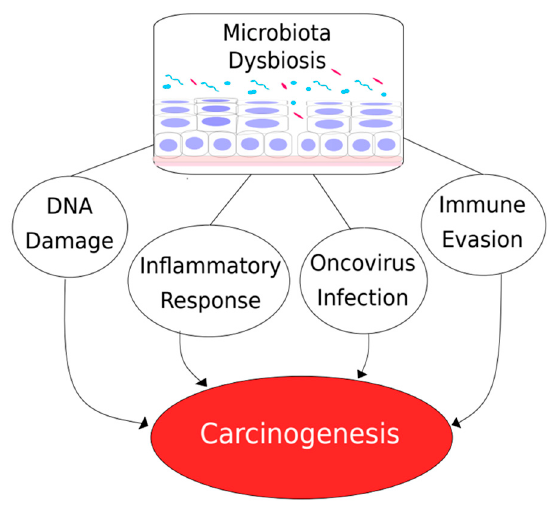
Figure 1. The impact of microbiota dysbiosis in carcinogenesis. Dysbiotic microbiota (blue and pink rods and circles) may drive carcinogenesis either by modulation of host mechanisms, such as promoting immune response alterations and DNA damage, or by directly eliciting tissue damage, thus facilitating infection by oncoviruses.